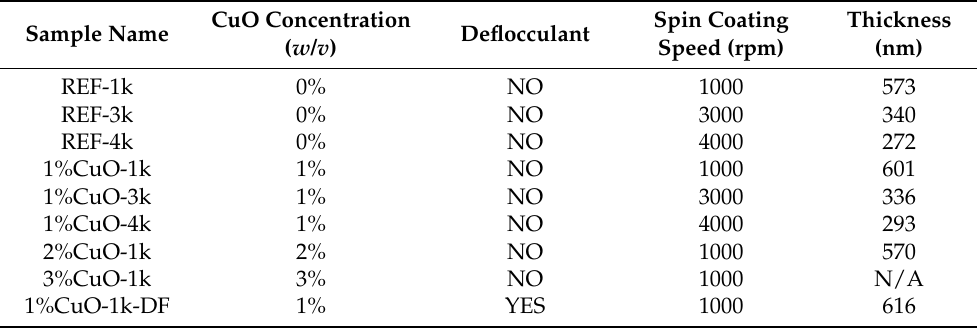
Table 1. Phase 1 samples coated with CuO/PMMA polymer nanocomposite solutions. REF-Yk correspond to films prepared by the 4% w / v PMMA-acetone solution without any nanofillers spin- coated at Y krpm. X%CuO-Yk correspond to films prepared containing X% w / v CuO nanofillers spin-coated at Y krpm. DF denotes the addition of